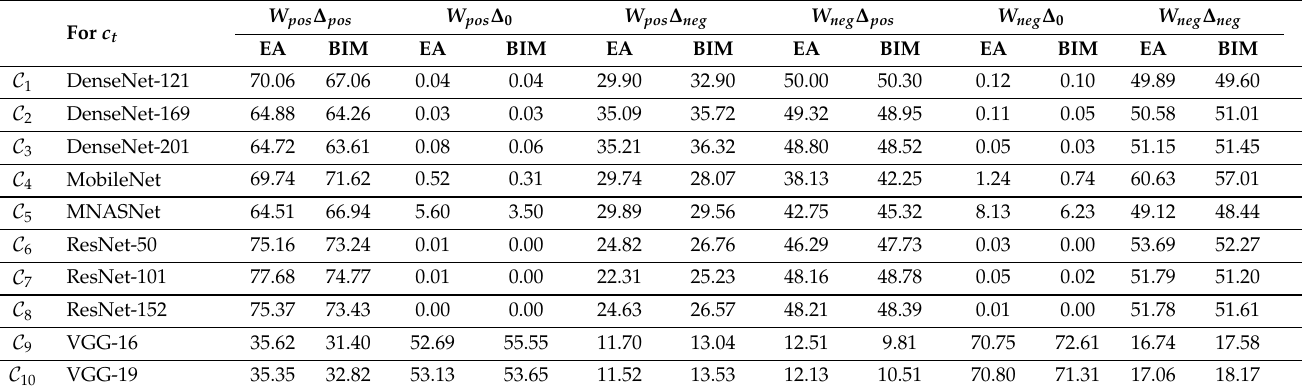
Table 6. For c t , average percentage of both positively related ( W pos , columns 2–4) and negatively related ( W neg , columns 5–7) units in which the activation increased ( ∆ pos ), stagnated ( ∆ 0 ), or de- creased ( ∆ neg